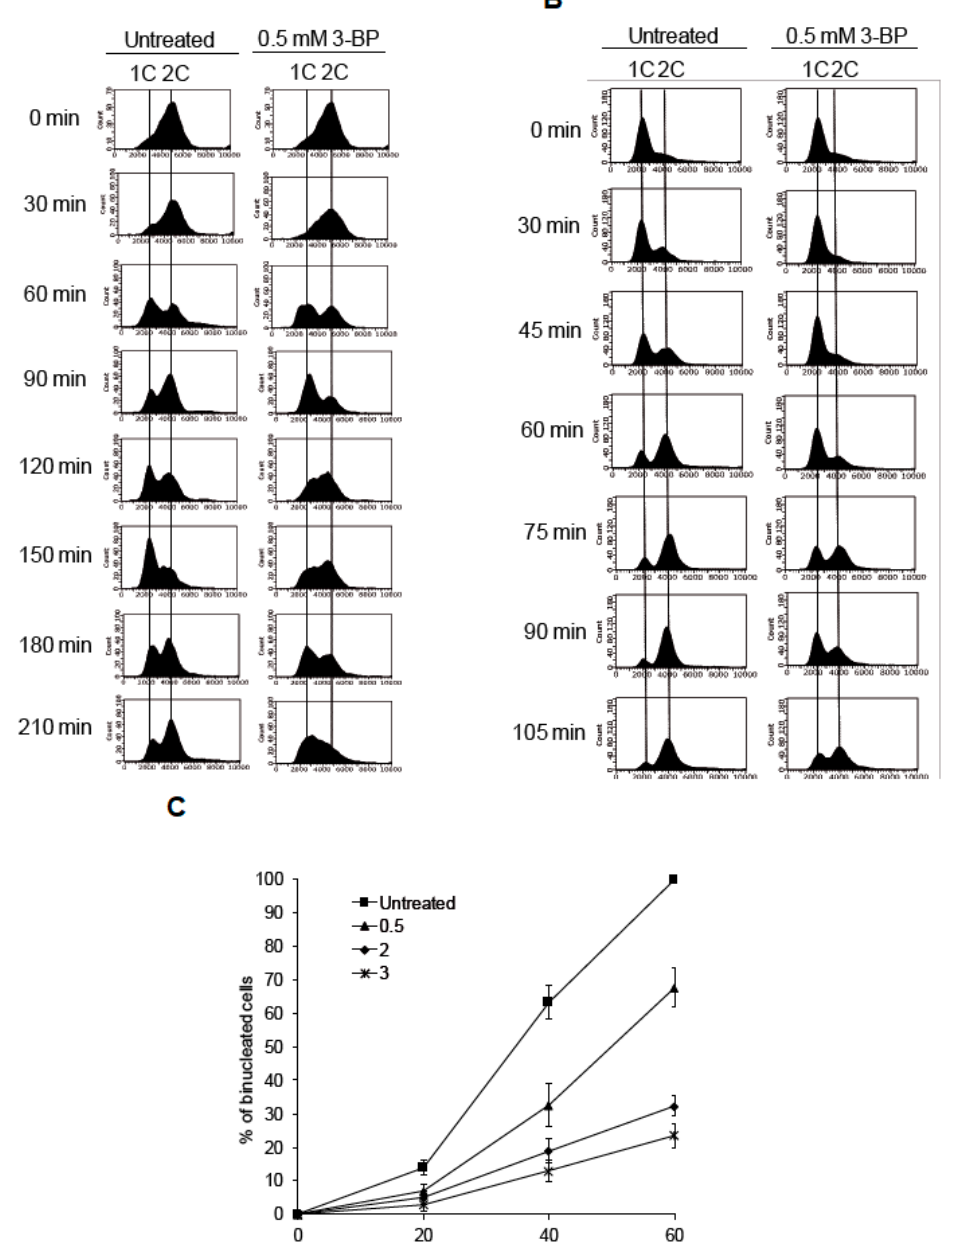
Figure 3. Cell cycle analysis of cells treated with 3-BP: ( A ) Cells exposed to 3-BP show slower progression through S phase of the cell cycle. Wild type cells were synchronized in G2 phase with nocodazole then washed and resuspended in fresh medium in the presence or absence of 3-BP. At indicated time points cells were collected and processed for flow cytometry analysis. ( B ) Cells treated with 3-BP accumulate at the G1 / S boundary. To determine the fraction of cells remaining in the G1 cell cycle phase after 3-BP exposure, an α -factor-nocodazole trap assay was performed. Cell cycle distribution was assessed by flow cytometry. ( C ) Presence of 3-BP delays cell progression into mitosis. Wild type cells were synchronized in G2 phase with nocodazole then washed and resuspended in fresh medium in the presence or absence of 3-BP. At indicated time points cells were collected and stained. The percentage of bi-nucleate cells was counted using fluorescent microscopy.